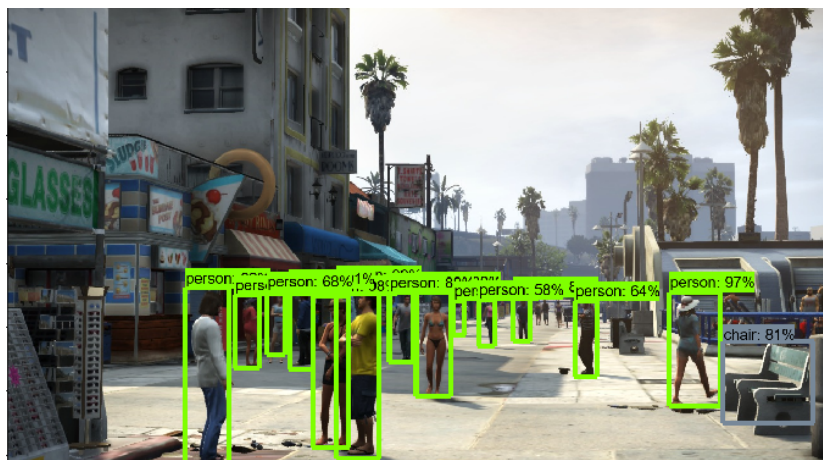
Figure 10. Image analysis through Faster R-CNN: